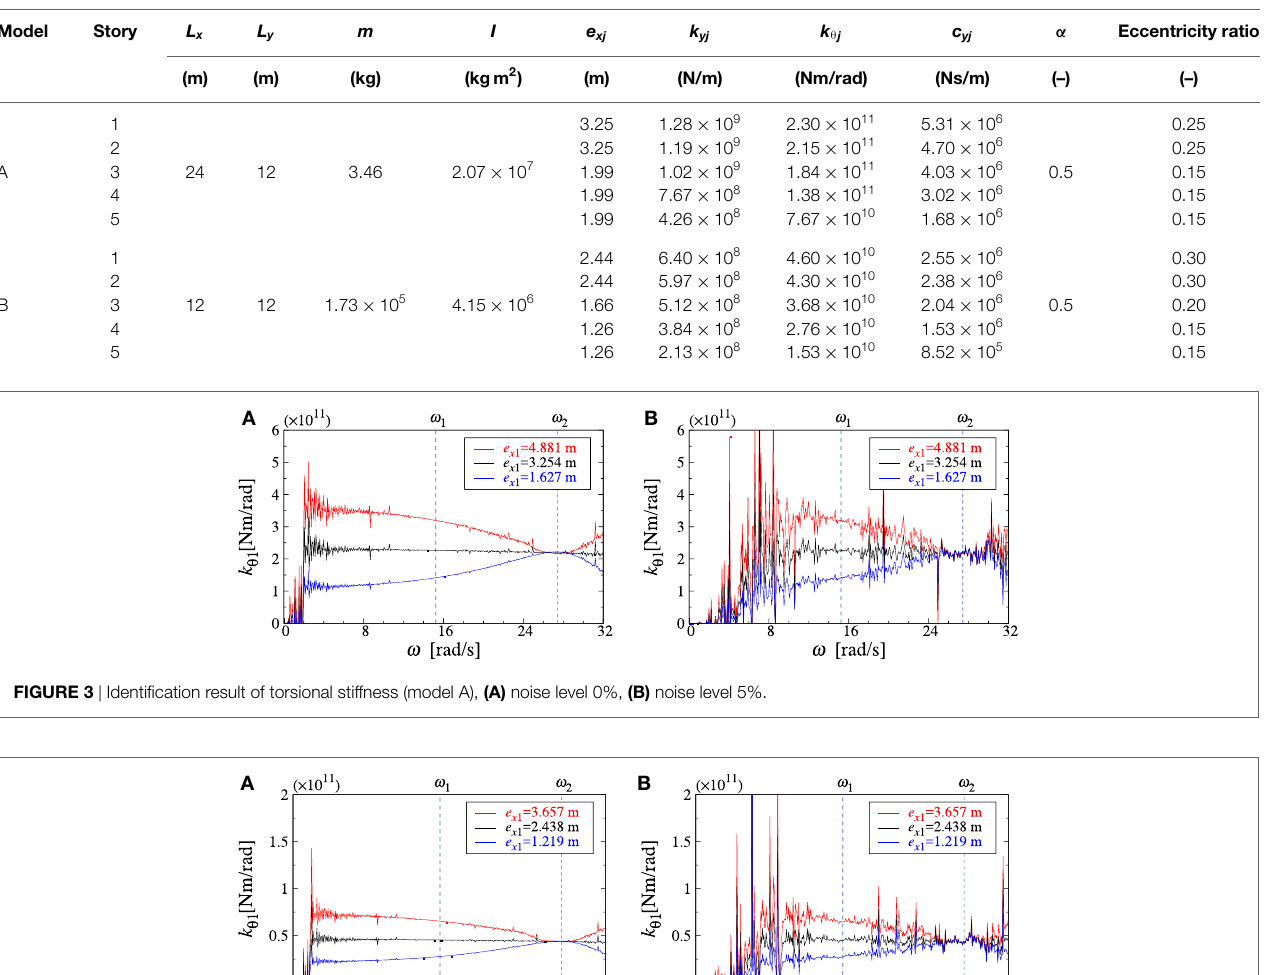
TABLE 1 | Physical properties of torsionally coupled